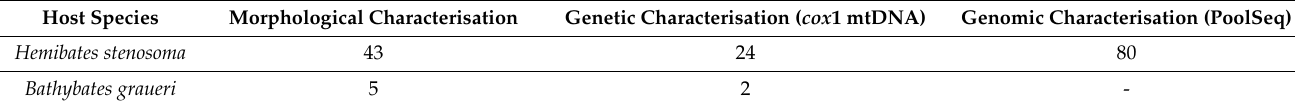
Table 1. Overview of specimens of Cichlidogyrus casuarinus being used in different parts of the study.